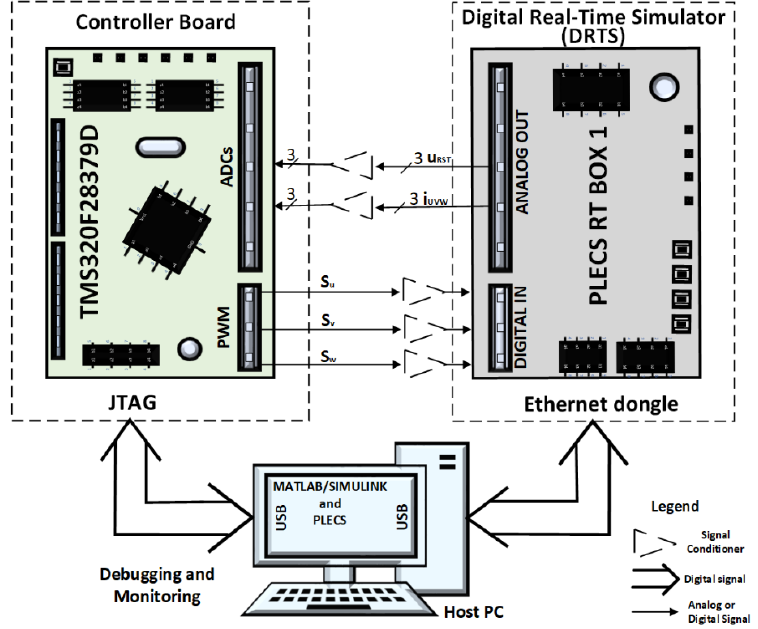
Figure 4. CHIL simulation